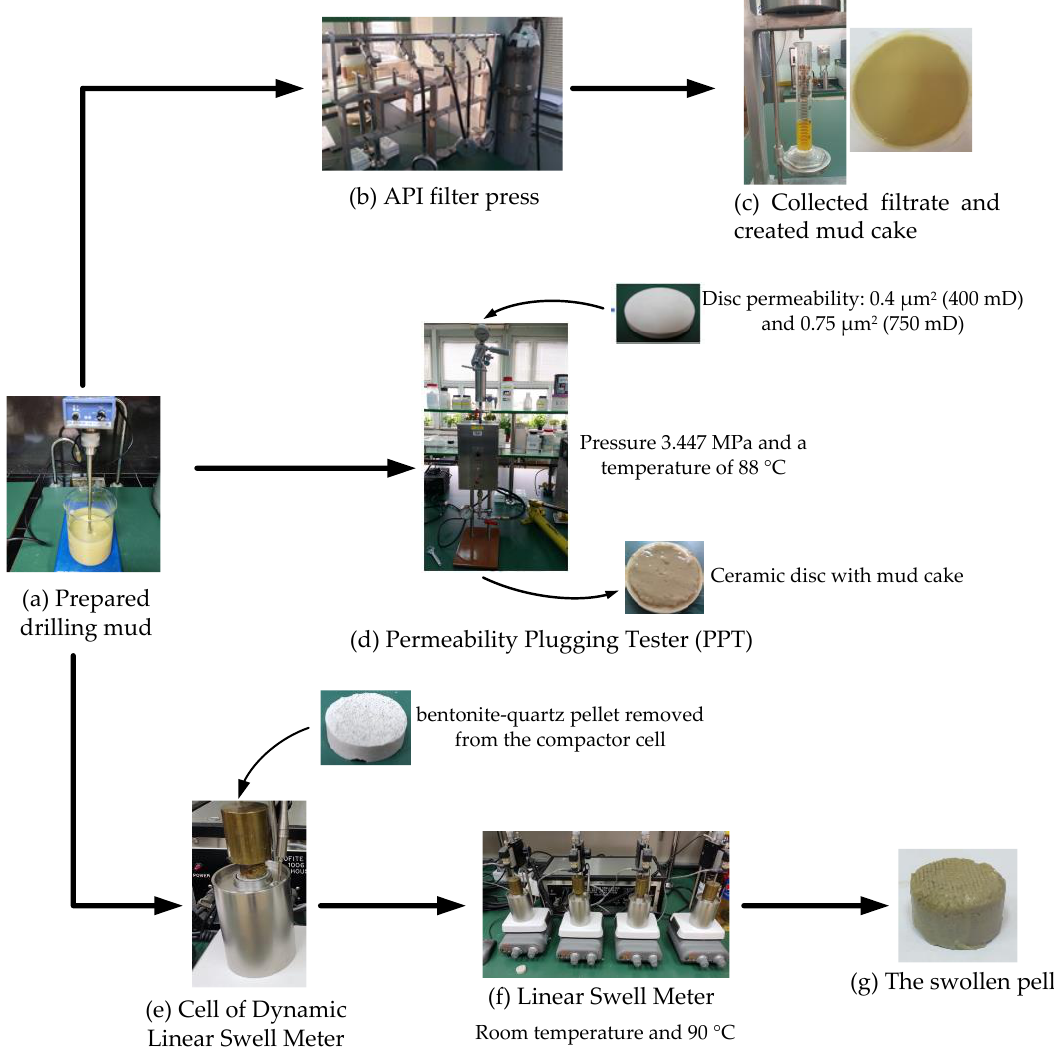
Figure 5. Used equipment and test procedures.